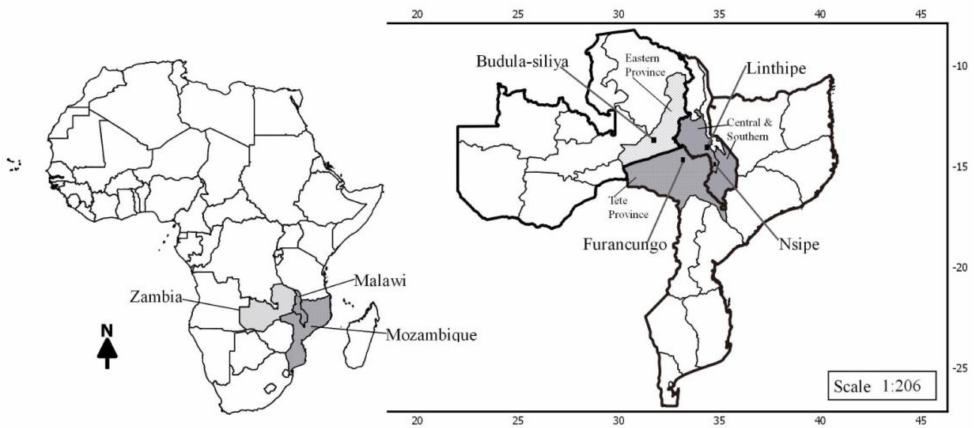
Figure 1. Map showing the location of the Chinyanja Triangle and research sites. The numbers on the map are the latitude and longitude of the specific research locations in